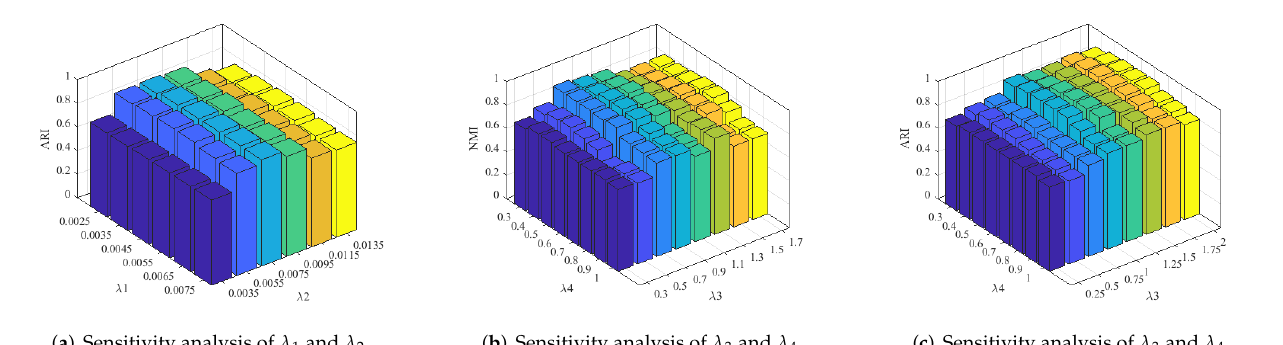
Figure 8. Sensitivity analysis of the proposed method with the evaluation metrics NMI and ARI. ( a ) Sensitivity analysis of λ 1 and λ 2 with ARI metric using Coil20 dataset, ( b ) Sensitivity analysis of λ 3 and λ 4 with NMI metric using Coil20 dataset. ( c ) Sensitivity analysis of λ 3 and λ 4 with ARI metric using UCSD